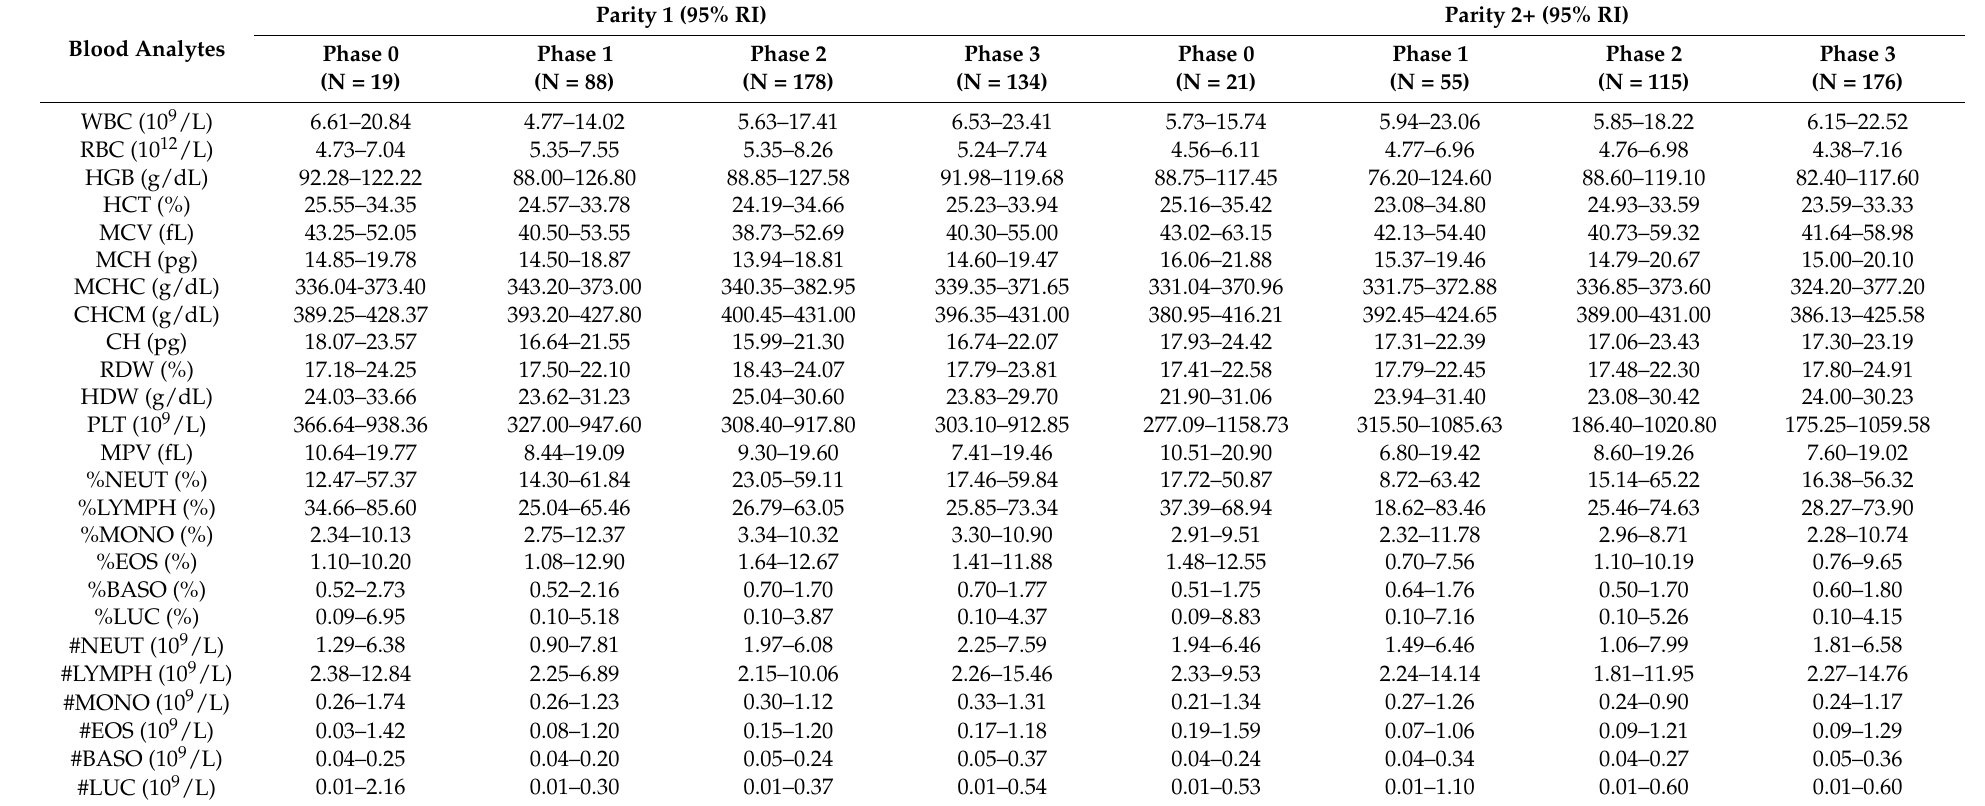
Table 6. Hematology RIs for Holstein cows when sorted by parities and lactation